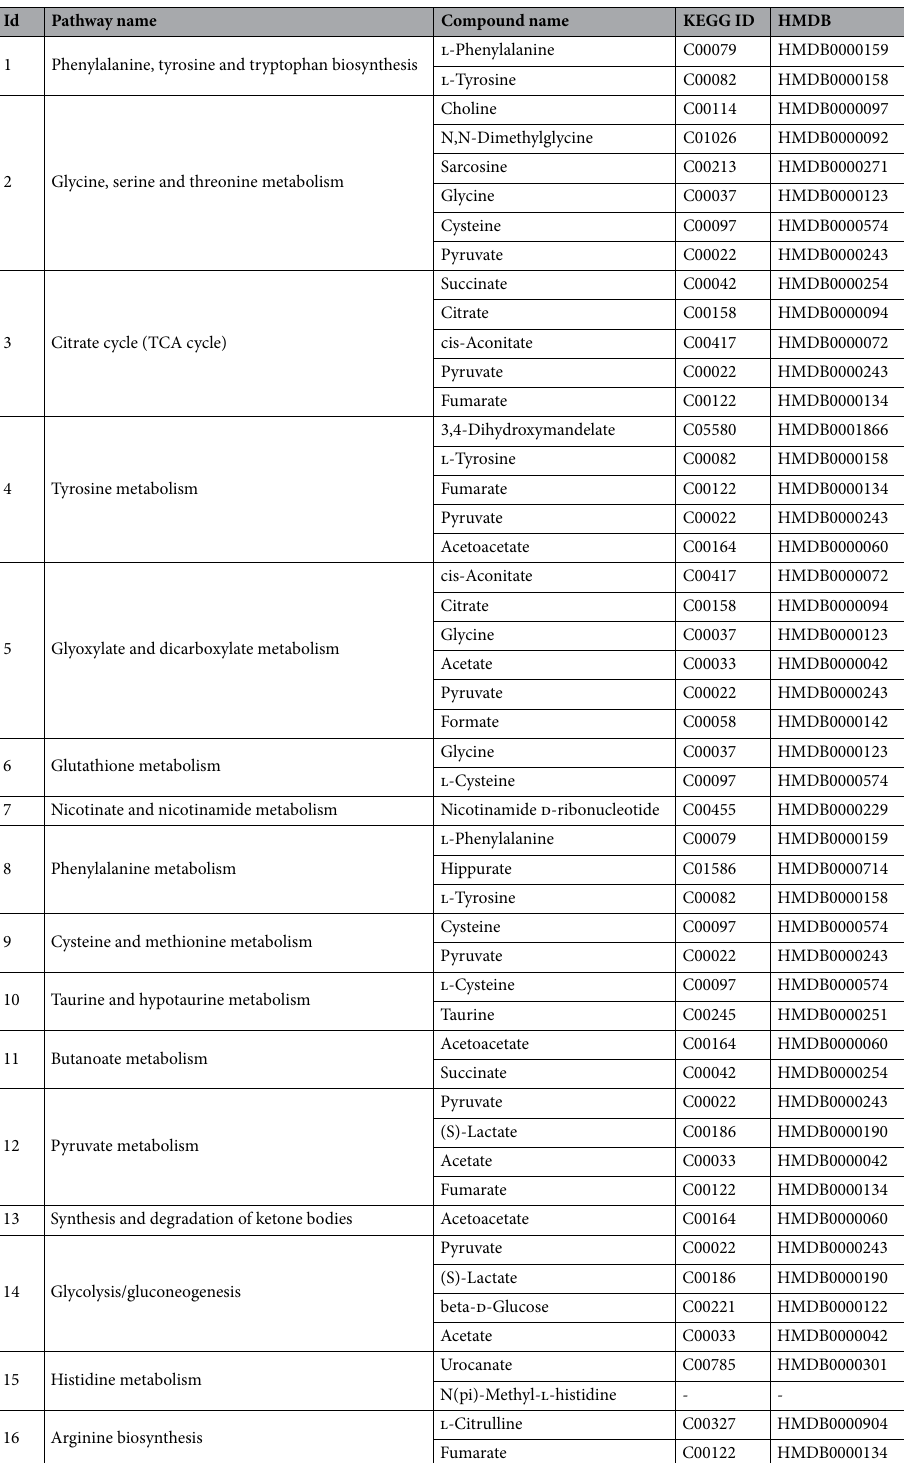
Table 2. KEGG Pathways of significantly different metabolites between sea level group and high-altitude Siachen